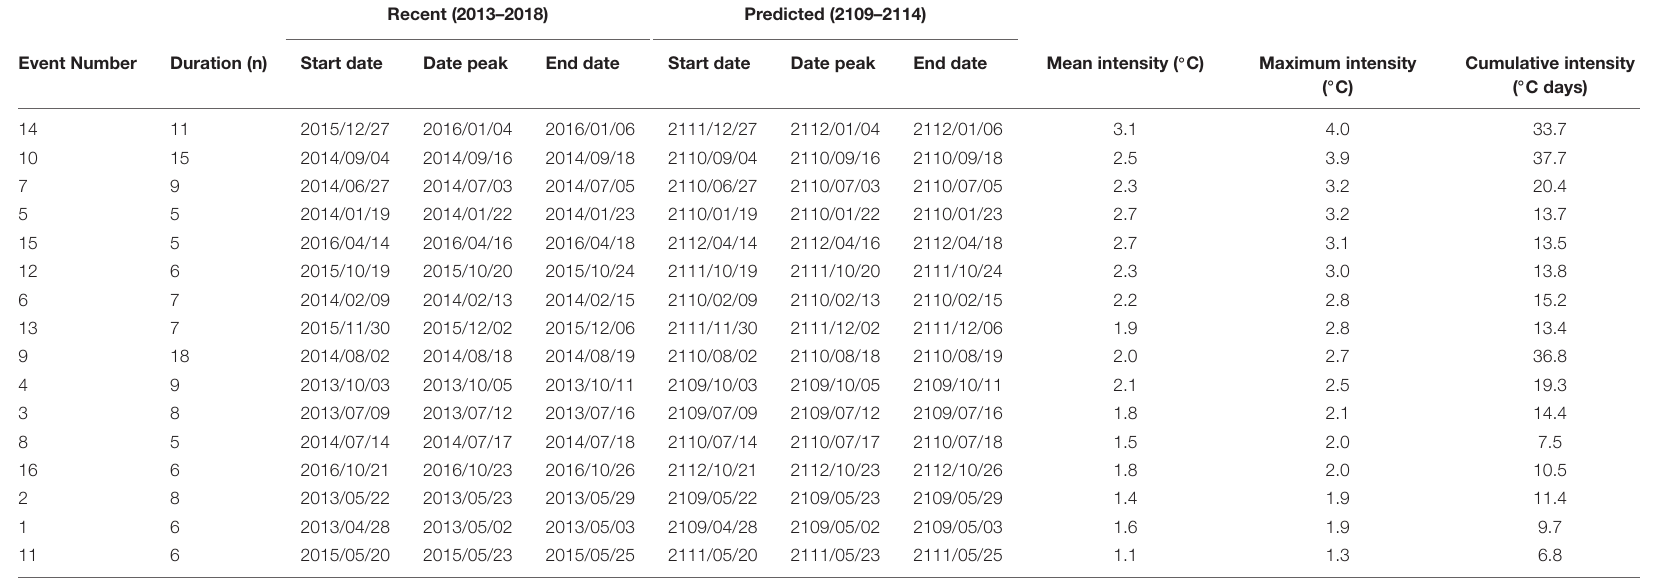
TABLE 2 | The number, duration (time from start to end dates of MHW event, in days), peak (day within duration of MHW event with highest temperature), mean intensity (mean temperature anomaly value relative to the climatological mean during the MHW event, in ◦ C), maximum intensity (highest temperature anomaly value relative to the climatological mean during the MHW event, in ◦ C), and cumulative intensity (sum of daily intensity anomalies over the duration of the MHW event, in ◦ C days) metrics for marine heatwave (MHW) events calculated from recent (2013–2108) and predicted (2109–2114) daily in situ water temperatures for the warm-temperate south-east coast study